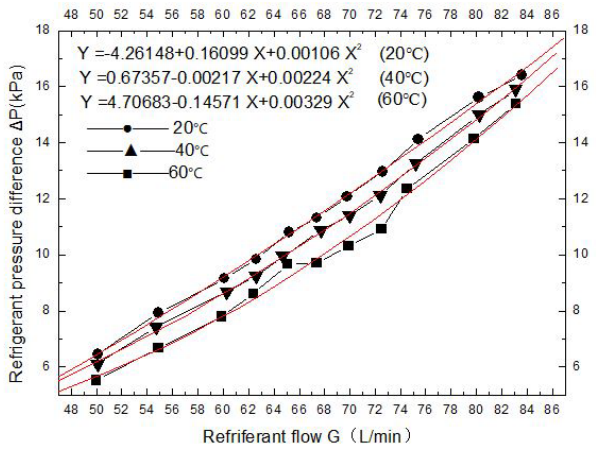
Figure 4. Variation in pressure drop with flow rate (imported pressure 200 kPa ).